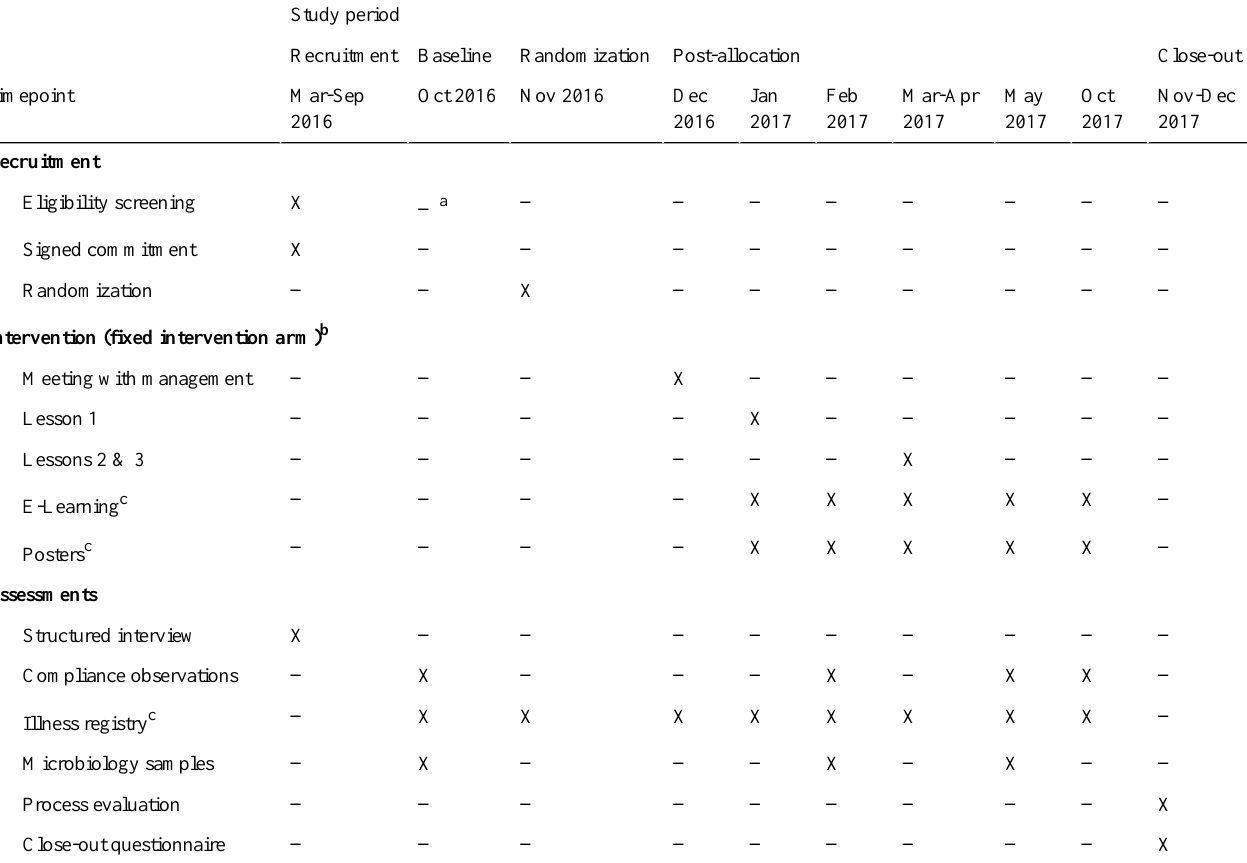
Table 2. Timeline of the